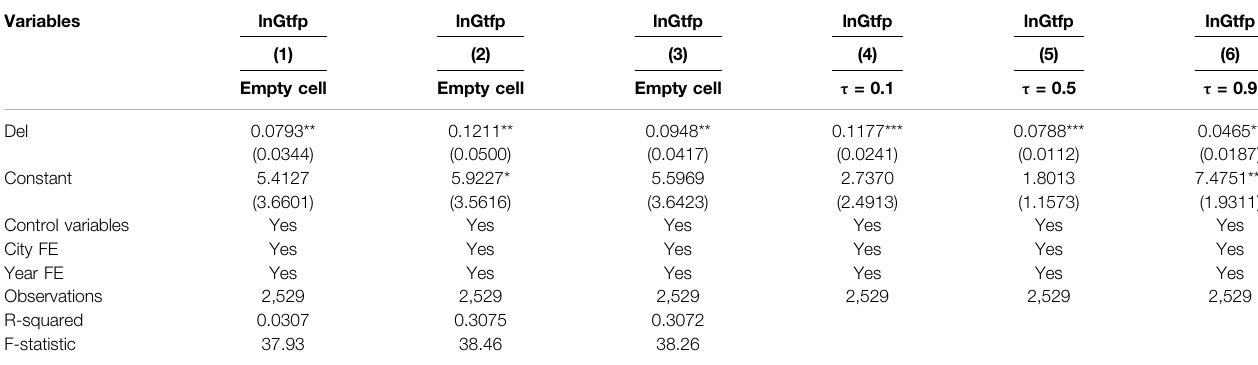
TABLE 2 | Robustness